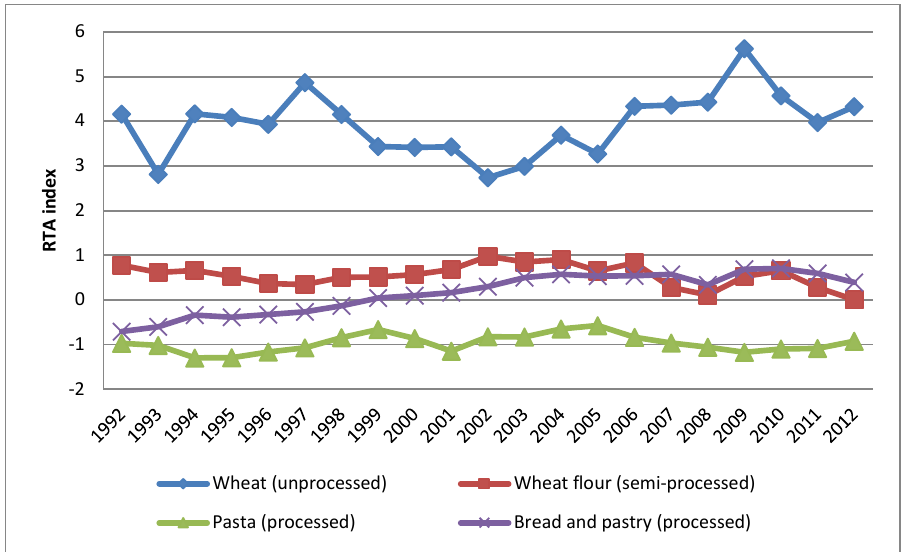
FIGURE A4: Trends in RTA index values for unprocessed, semi-processed and processed wheat